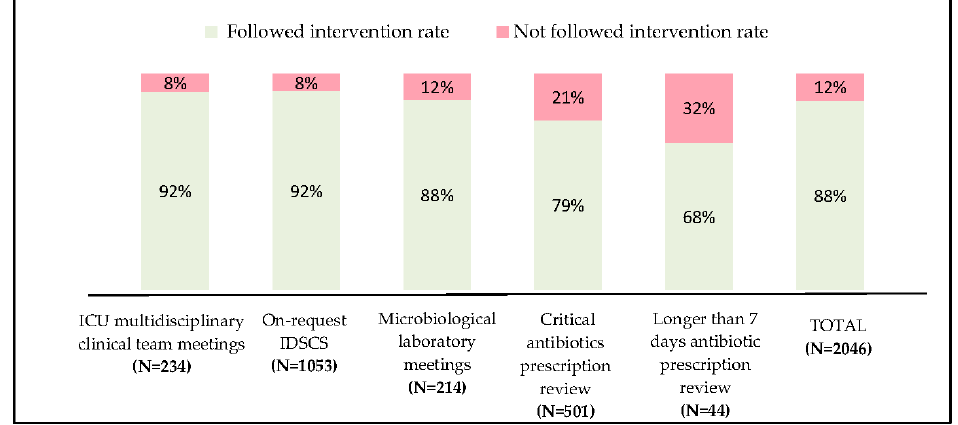
Figure 1. Interventions’ distribution. Distribution of the 2046 interventions noted in the electronic patient record related to 1430 hospital stays and 1243 patients. Abbreviations: ICU, intensive care unit; IDSCS, infectious diseases specialist consulting service .